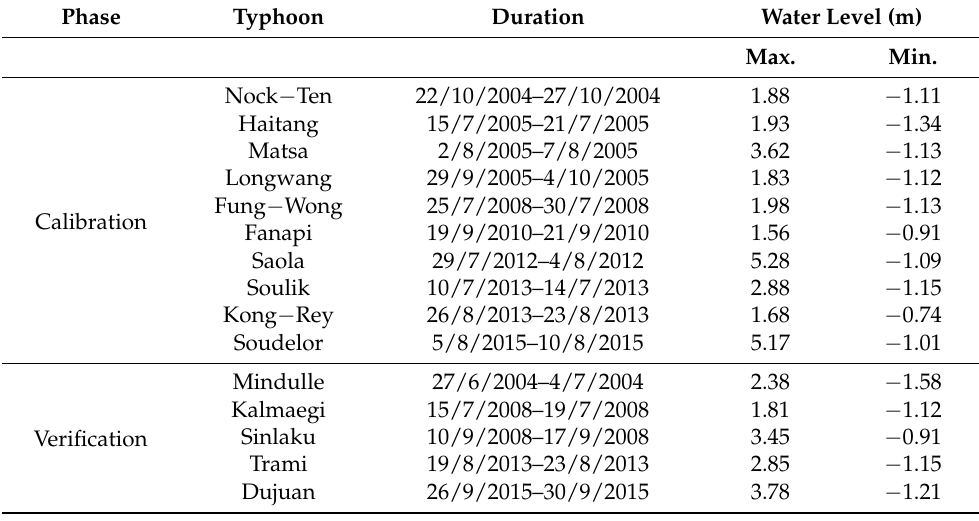
Table 1. Summary description of water levels at the Taipei Bridge during